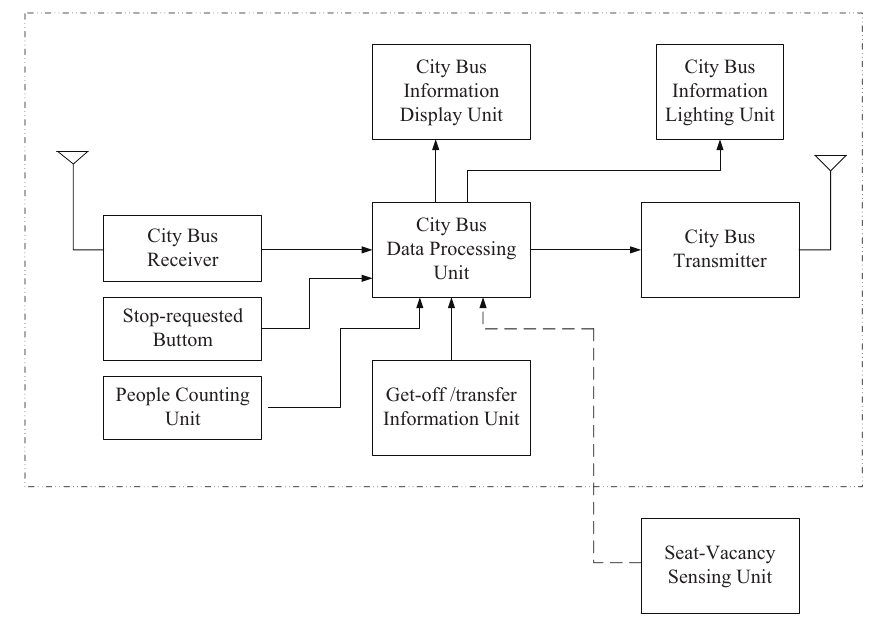
Figure 8. The major components of a real-time passenger information system. Notice that a triangle pointing down represents an antenna.